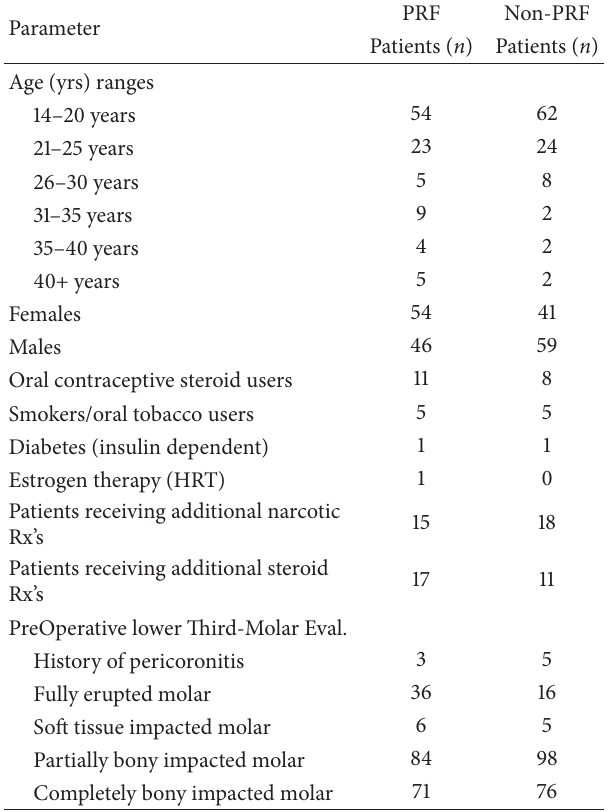
Table 1: Total study patient clinical